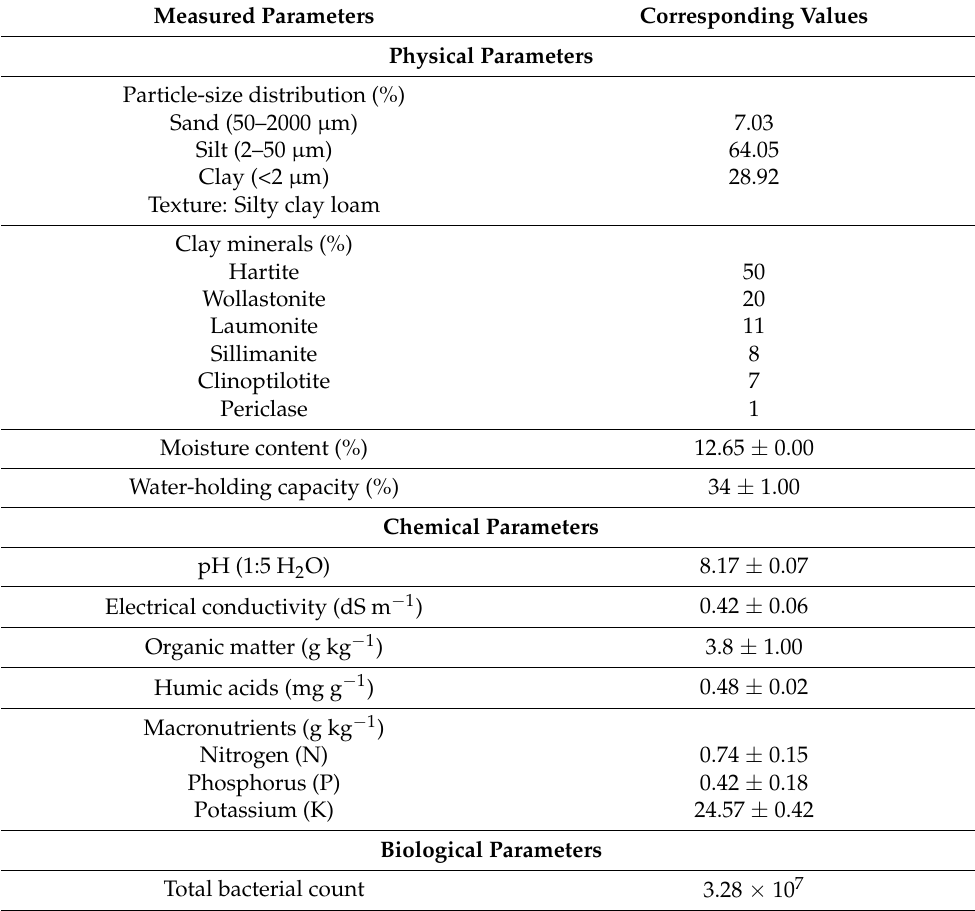
Table 1. Physical, chemical, and biological properties of the cropland soil used in the greenhouse trial. Data are presented as mean values ± standard deviation ( n =